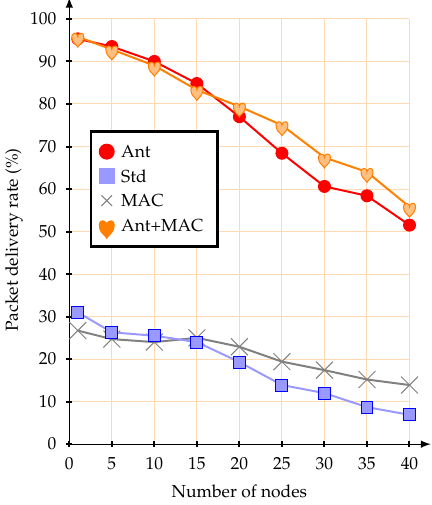
Figure 10. Average packet delivery rate at 5